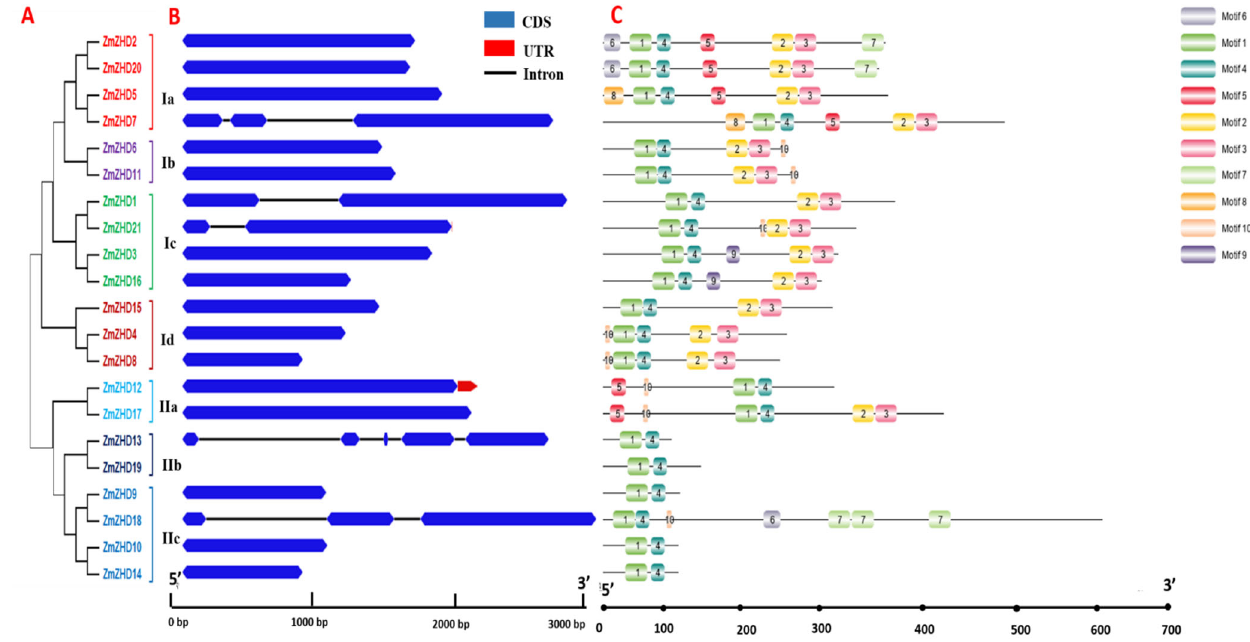
Figure 3. The phylogenetic relationships, conserved motifs, and gene structures of ZmZHD proteins and ZmZHD genes. ( A ) A maximum likelihood (ML) phylogenetic tree of the maize proteins was constructed from full-length sequences in MEGA 11.0 with 1000 bootstrap replicates. ( B ) The gene structures of the ZmZHD genes include introns (black lines), exons (blue rectangles), and untranslated regions (UTRs, red rectangles). The scale bar indicates 0.5 kb. ( C ) Distribution of conserved motifs in the ZmZHD proteins. The colored boxes represent Motifs 1–10. The scale bar indicates 100 aa.